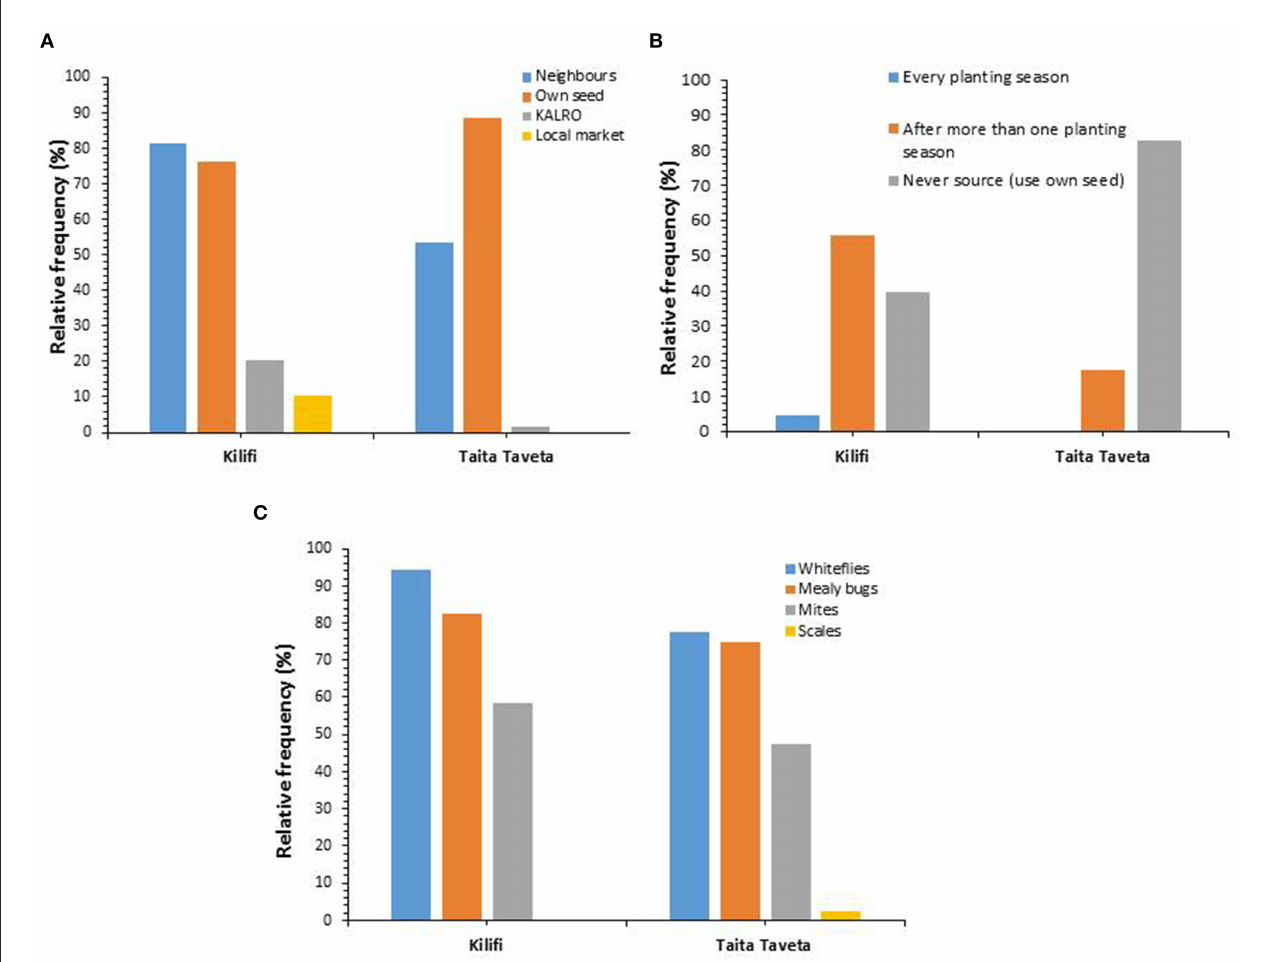
FIGURE1 Farmers knowledge on: (A) sources of cassava planting material, (B) frequency of sourcing cassava planting material, and (C) presence of pests on cassava planting material in Kilifi and Taita-Taveta Counties.